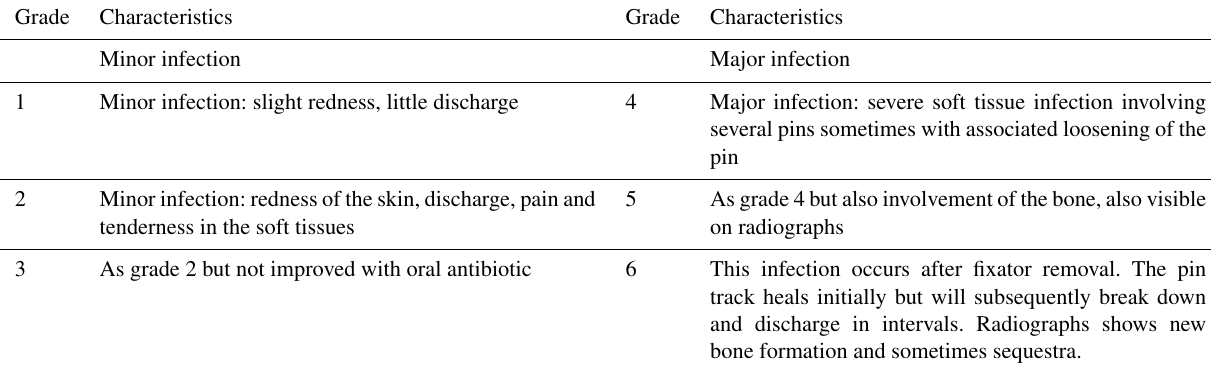
Table 1. Checketts–Otterburn classification (Checketts et al., 1993) grades pin site infections into minor infection (CO 1–3) and major infection (CO 4–6). Neither infection nor inflammation grades as CO